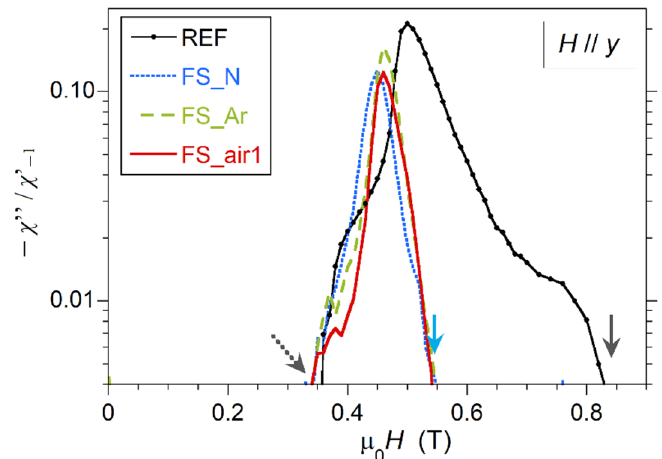
Figure 8. χ ’’( H ) for the same samples and under the same conditions as in Figure 7a, but in this case μ 0 h 0 = 100 μT. χ ’’ is plotted in a log scale. The dotted arrow indicates the estimated μ 0 H c2 value for these samples. Note that the two continuous arrows point to the same DC field values as in Figure 7a, to allow for a direct comparison between the two sets of data.